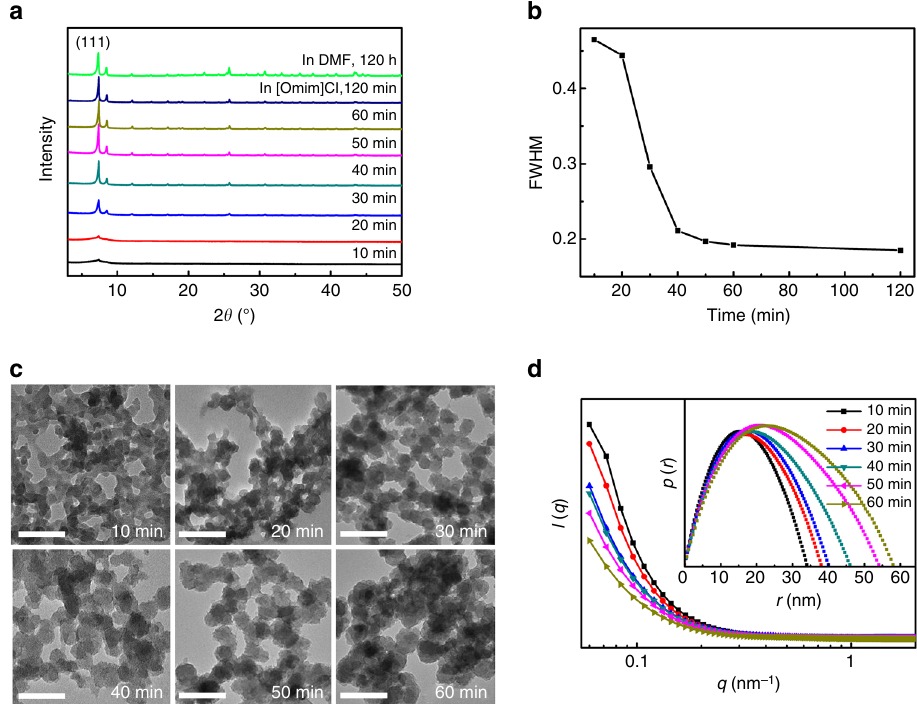
Fig. 1 Crystallization of UiO-66 in [Omim]Cl with reaction time. a XRD patterns of the products synthesized in [Omim]Cl with different reaction time and in DMF with reaction time of 120 h. b The full-width half-maximum FWHM of the (111) re fl ection of the products synthesized in [Omim]Cl against reaction time. c TEM images of the products synthesized in [Omim]Cl with different reaction time. Scale bar, 200 nm. d In situ SAXS pro fi les and pair-distance distribution function curves (the inset) of the reaction systems for UiO-66 synthesis in [Omim]Cl at different reaction